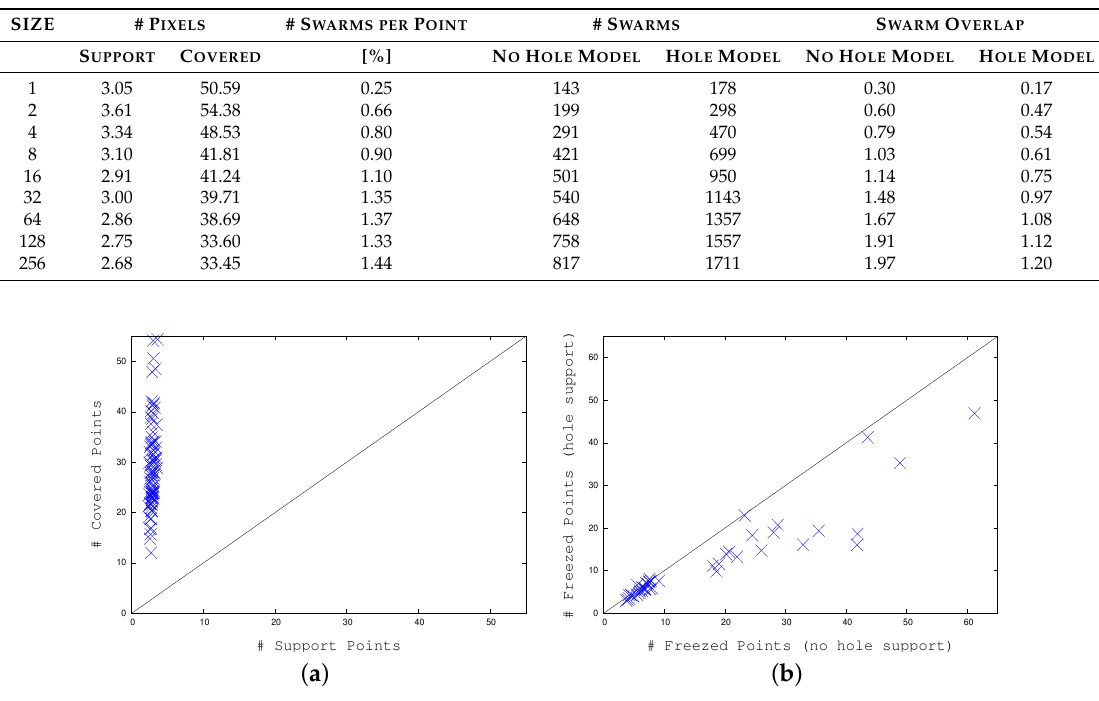
Figure 16. ( a ) Number of support points versus number of base movement tracking algorithm (BMTA)-represented points by a single swarm. ( b ) Number of frozen points with no hole support versus number of frozen points with hole